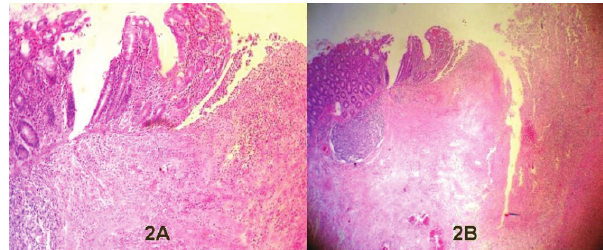
Figure 2 - (2A) Congestion, exudate and ulcer base with inflammation (H&E x10). (2B) Perforation along whole thickness of the bowel wall with exuda and erosion